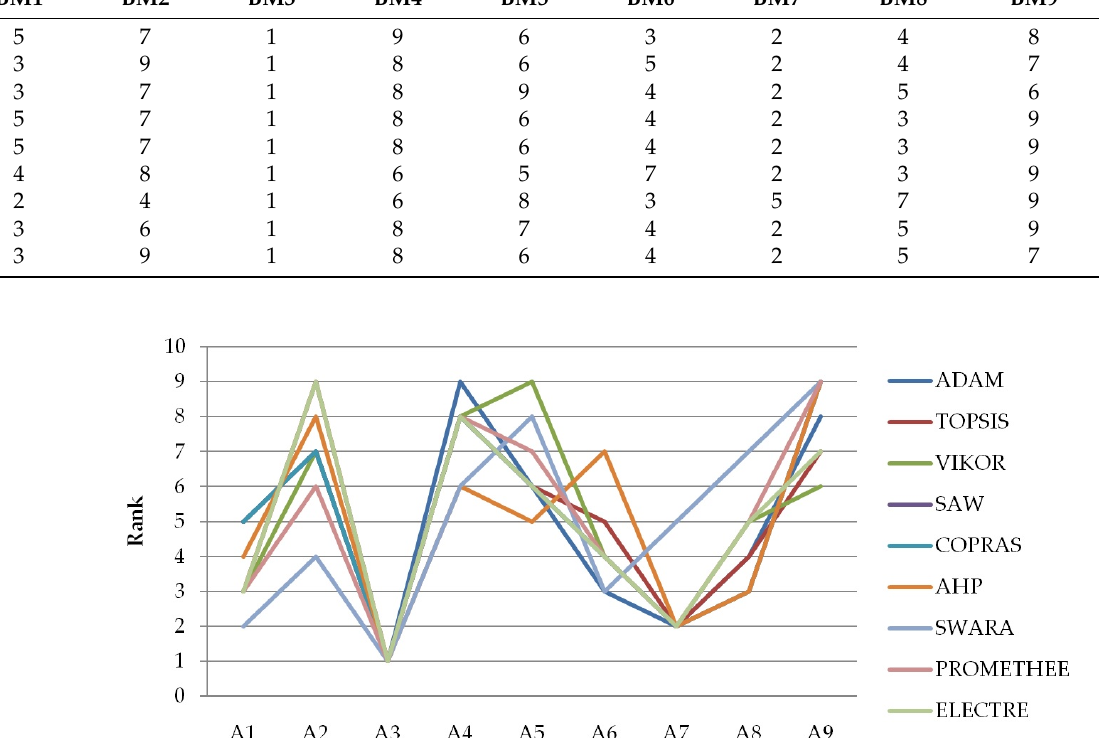
Figure 4. Comparisons of rankings by various MCDM methods.